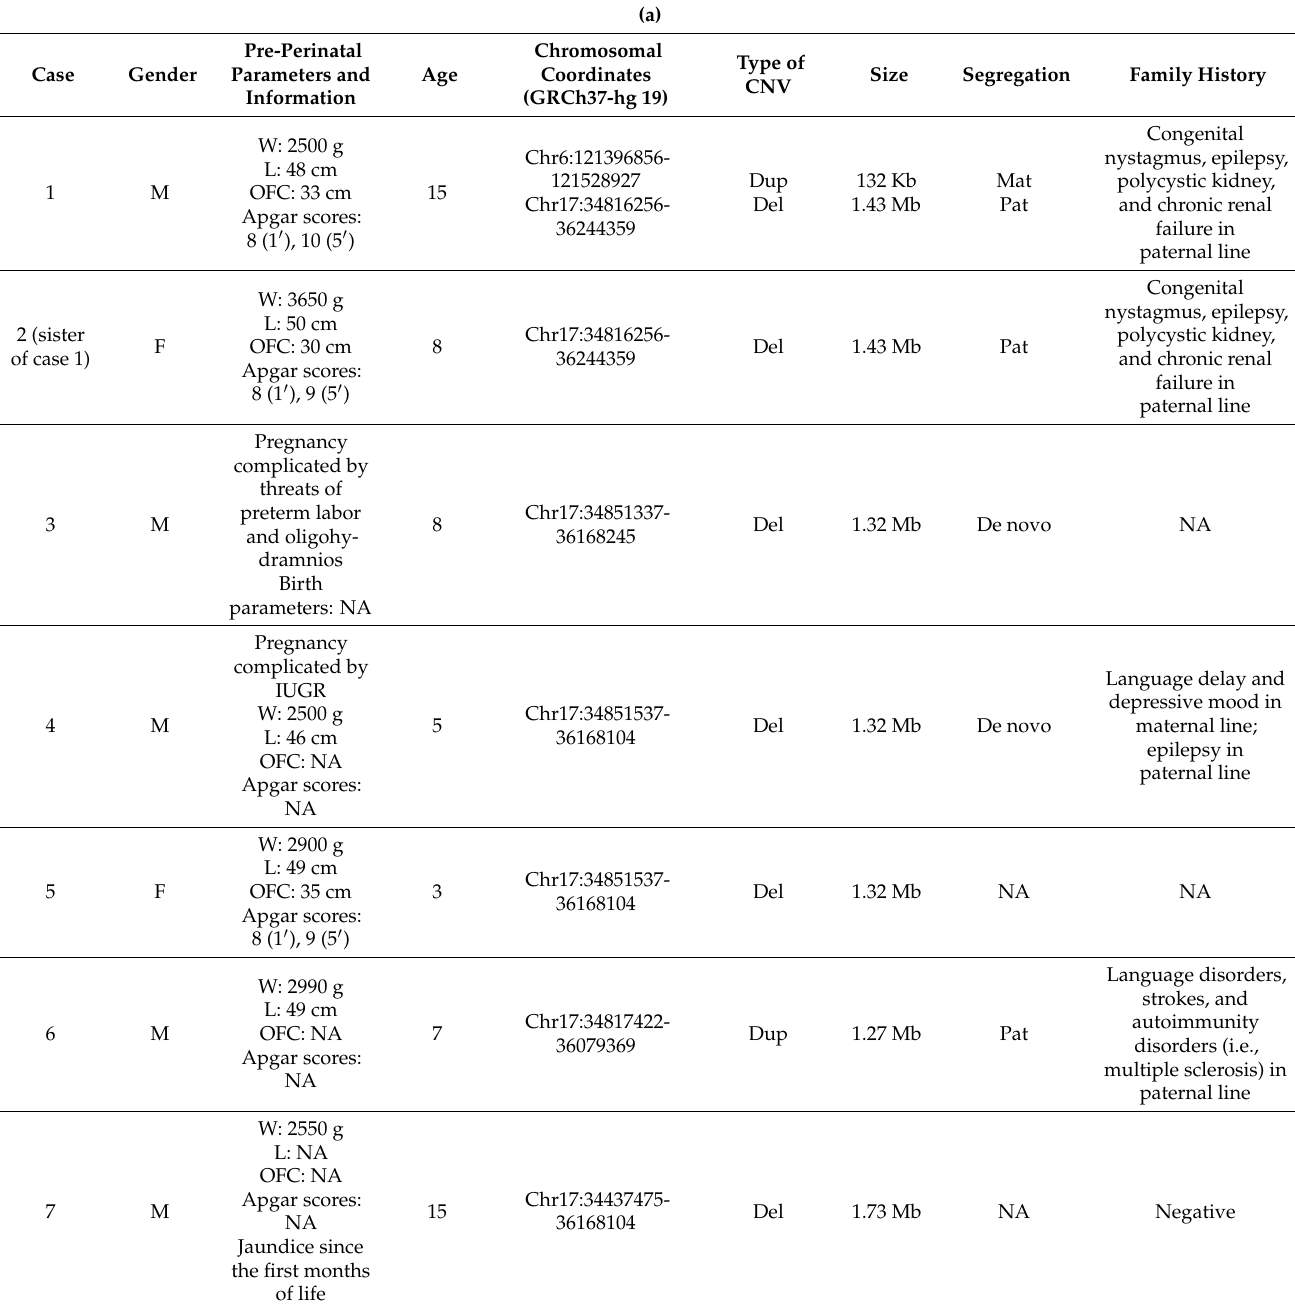
Table 1a (Demographic distribution and genetic findings) and Table 1b (Patients’ pheno- typic characterization). Table 1. Genetic and neuropsychiatric features of the 12 patients. ( a ): Demographic distribution and genetic findings. ( b ): Patients’ phenotypic